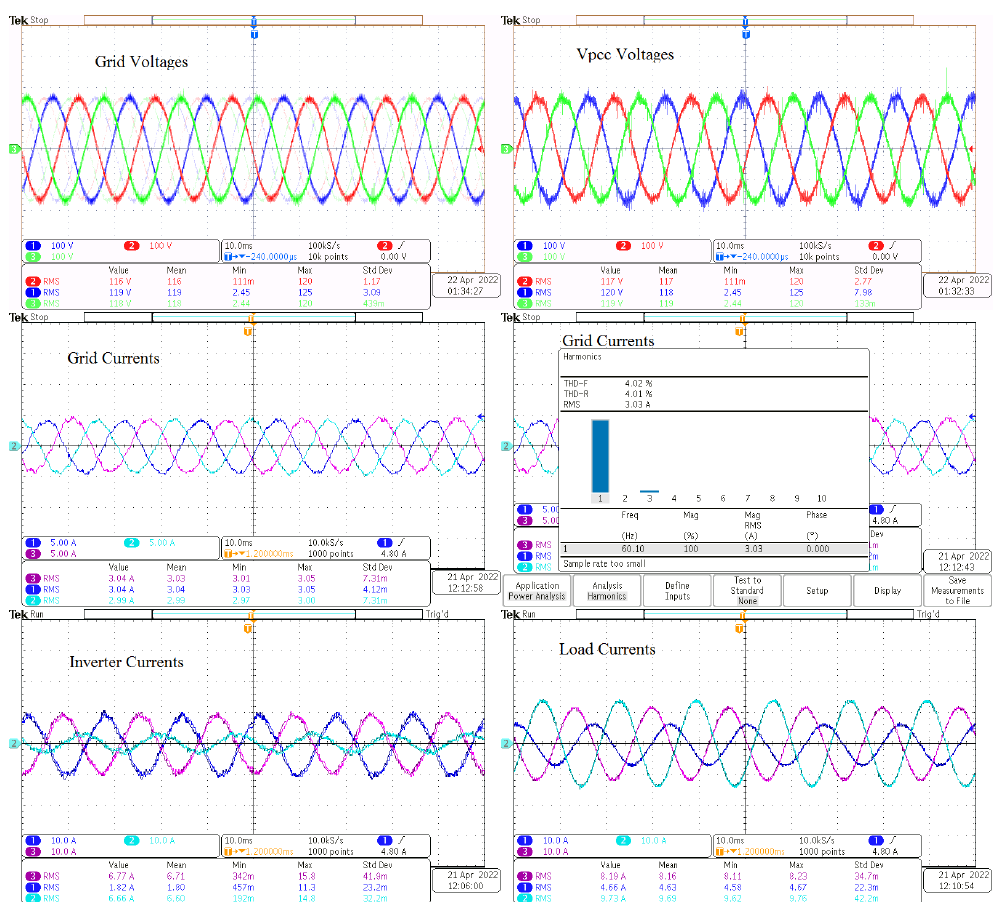
Figure 15. Experimental results at P = − 1 kW, Q = 500 var using Tektronix MDO3024 oscilloscope.